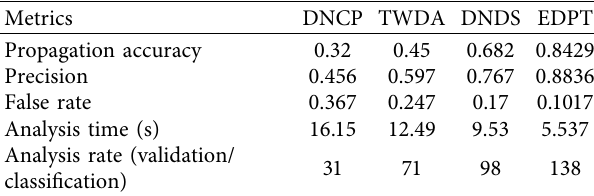
Table 2: Discussion summary for accumulation %.